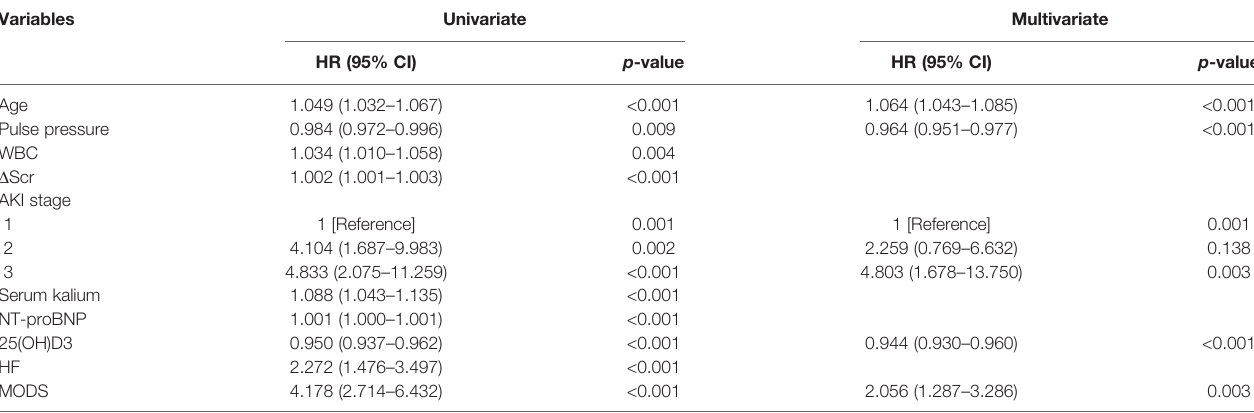
TABLE 2 | Analysis of risk factors for prognosis in the development cohort (univariate and multivariate Cox